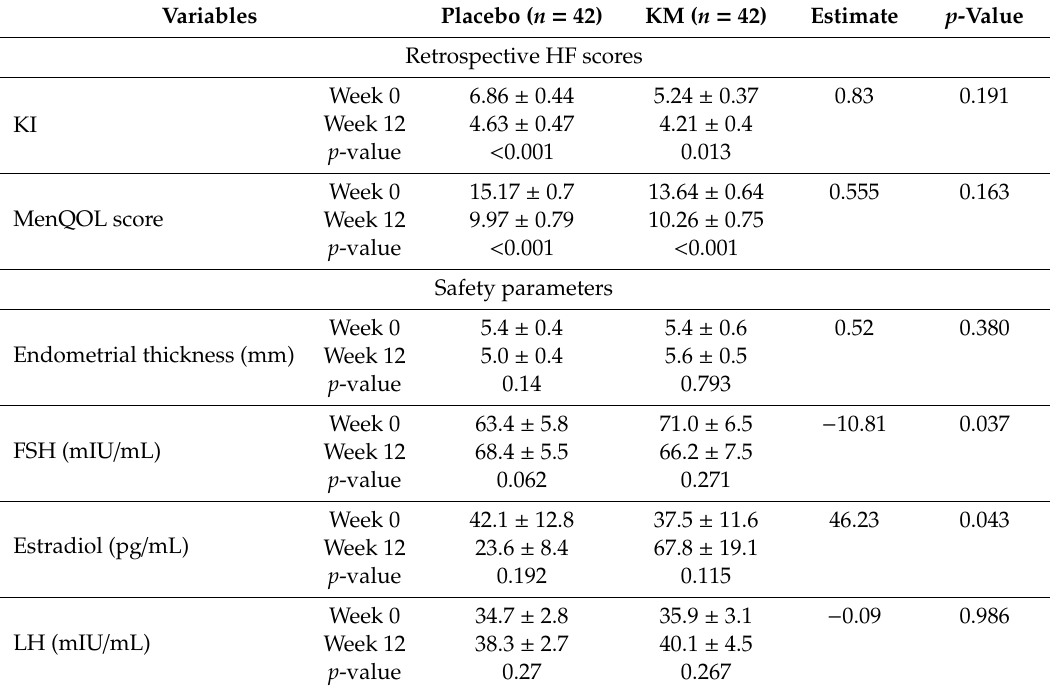
Table 2. Changes in retrospective HF scores and safety